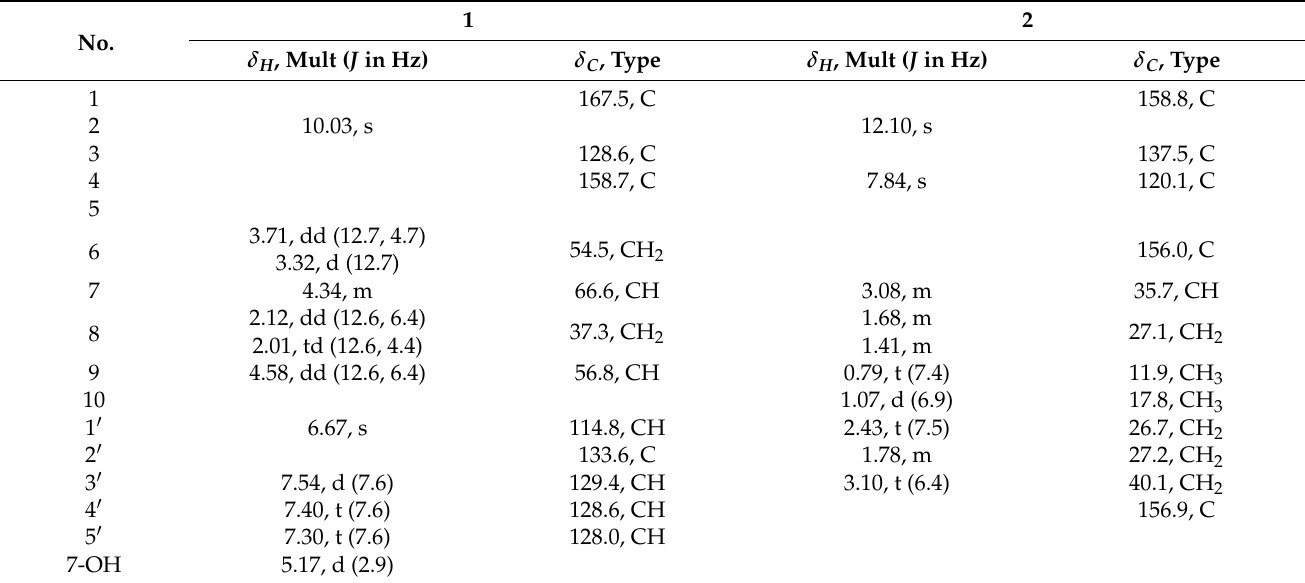
Table 1. 1 H (600 MHz) and 13 C (150 MHz) NMR data for 1 and 2 .